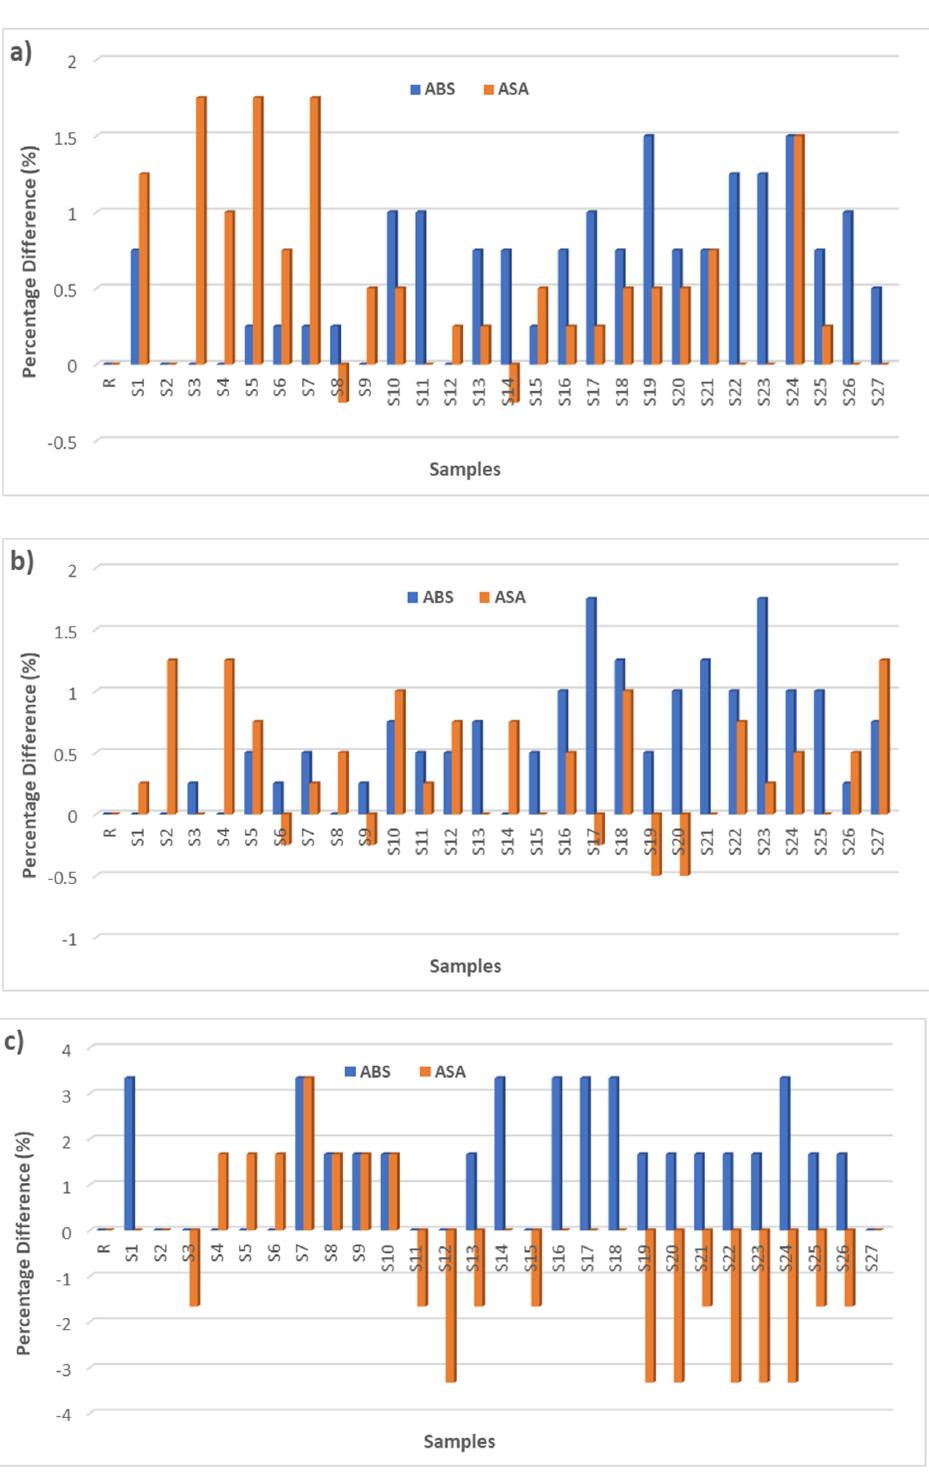
Figure 1. Percentage change for the dimensional analysis of ABS and ASA: ( a ) along X-axis; ( b ) along Y-axis; ( c ) along Z-axis.